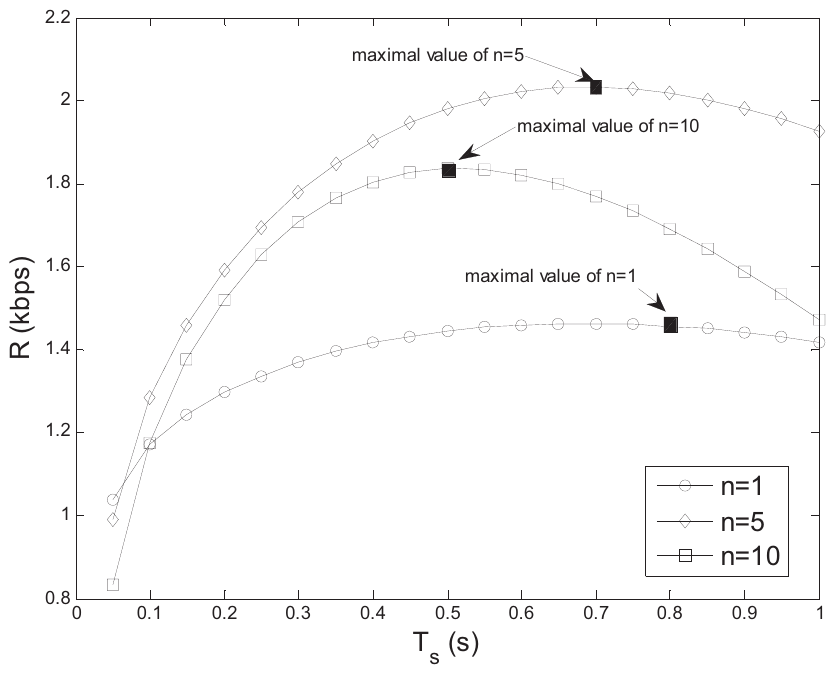
Figure 9. Average throughput vs. sensing